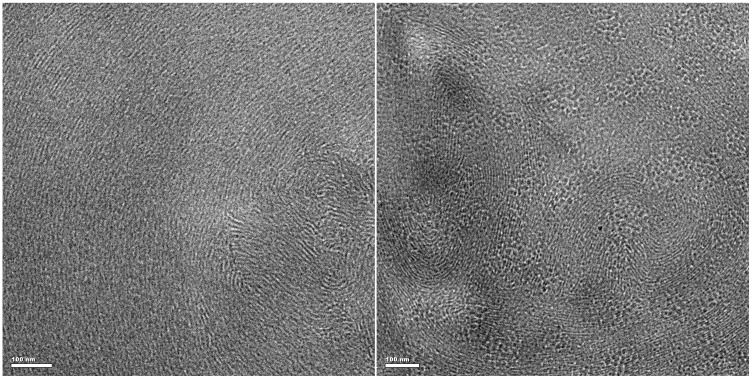
Cryo-TEM images.(a) Cryo-TEM image of the 70 mM C16MDB/35 mM SL solution; (b) Cryo-TEM image of the 70 mM C16MDB/40 mM SL solution.